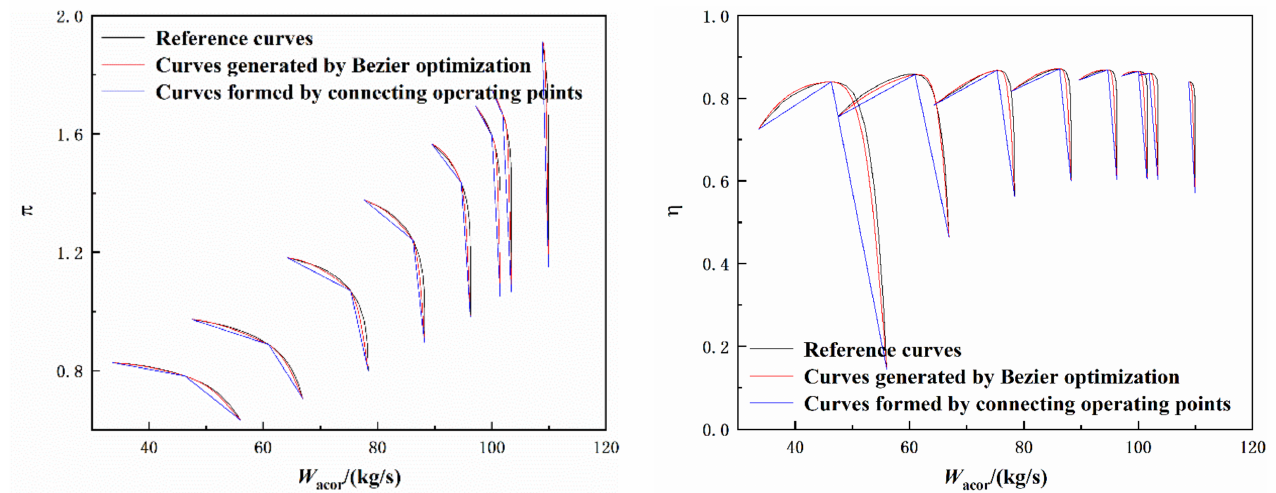
Figure 9. Comparison between the characteristic map generated by Bezier curve optimization and the original characteristic